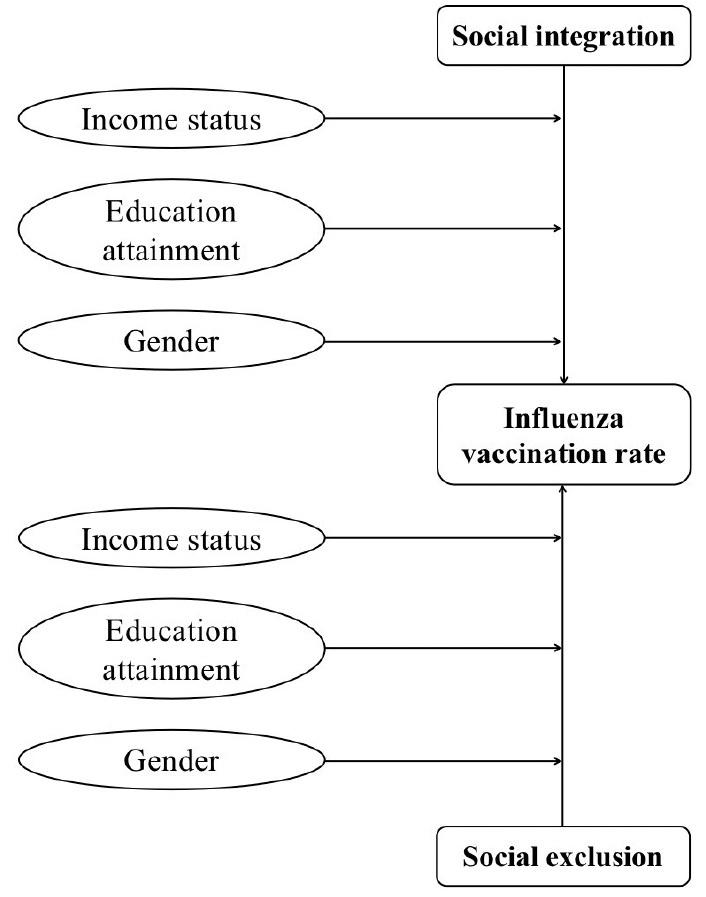
Figure 1. Conceptual framework of this study.